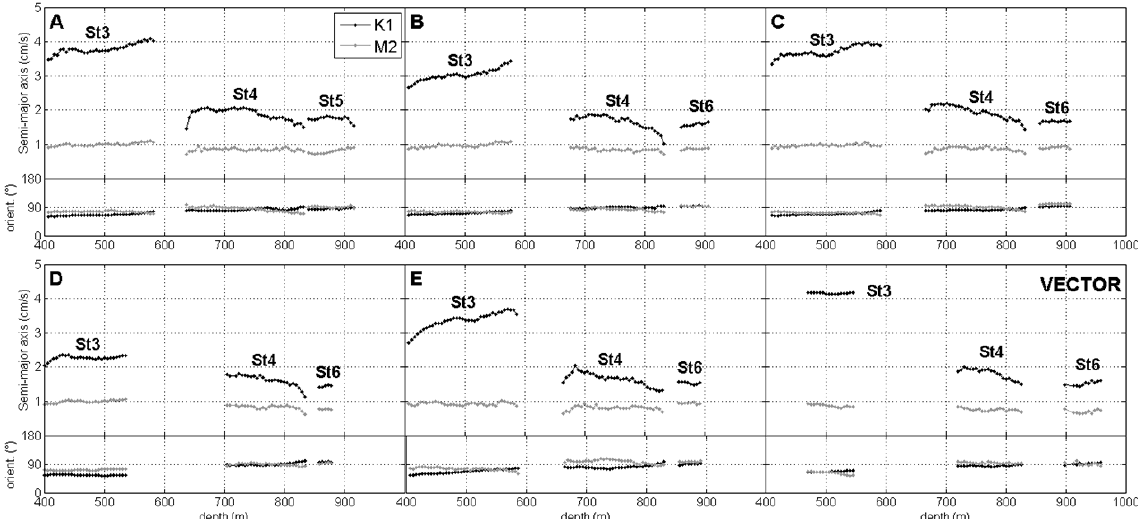
Fig. 9. Semi-major axes for K1 (black dots) and M2 (grey dots) with tidal ellipse orientation angle (in degrees anticlockwise from East) as a function of depth. The semi-axes were calculated with harmonic analysis for the bottom current meters along the Otranto section, from MATER (periods A, B, C, D and E) and VECTOR data. Note that during period A, to avoid overlapping, the semi-major axes at St5 are plotted adding 60m to the true